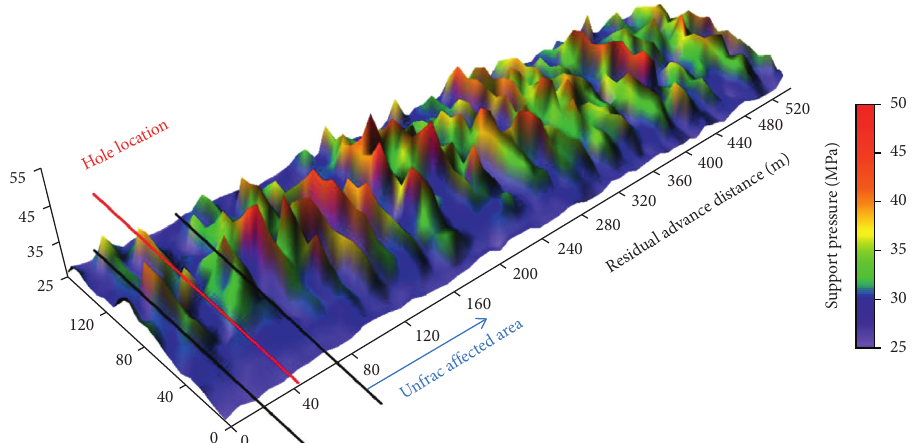
Figure 19: Variation characteristics of mine pressure within the fracturing drilling field of 4 combined tunnels with return air in the 31305 mining